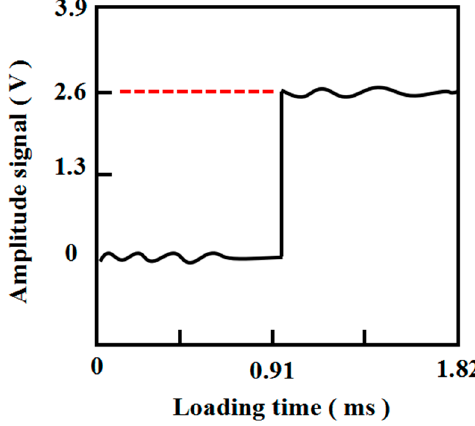
Figure 14. Loading acceleration of dropping system.